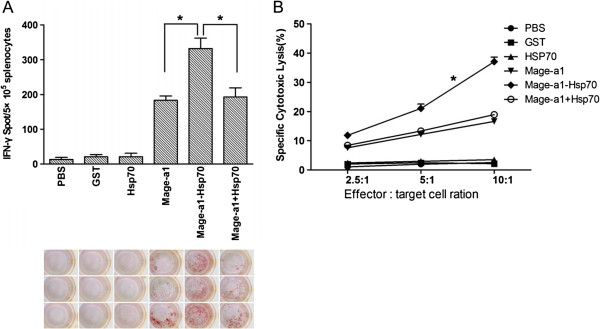
T-cell-mediated immune response after vaccination with Hsp70-Mage-a1 fusion protein. C57BL/6 mice were immunized with purified GST, Hsp70, Mage-a1, Mage-a1-Hsp70 fusion protein or Mage-a1 + Hsp70 and then administered a booster immunization after one week. Two weeks after the booster, pooled splenocyte cultures were prepared and re-stimulated. A. IFN-γ-producing T cells in splenocytes of immunized mice were quantified by using ELISPOT. Data are presented as mean ± SE of three separate experiments. Statistical analysis by one-way ANOVA revealed that mice vaccinated with Mage-a1-Hsp70 generated more IFN-γ spots than Mage-a1 or Mage-a1 + Hsp70 (* p < 0.001). B. The CTL response induced in splenocytes of immunized mice was determined by using CytoTox 96 nonradioactive cytotoxicity assay. Data are presented as mean ± SE of three separate experiments. Statistical analysis by two-way ANOVA revealed that Mag-a1-specific lysis of CTLs from mice vaccinated with Mage-a1-Hsp70 was higher than those vaccinated with Mage-a1 or Mage-a1 + Hsp70 at all effector: target cell ratios (* p < 0.001).